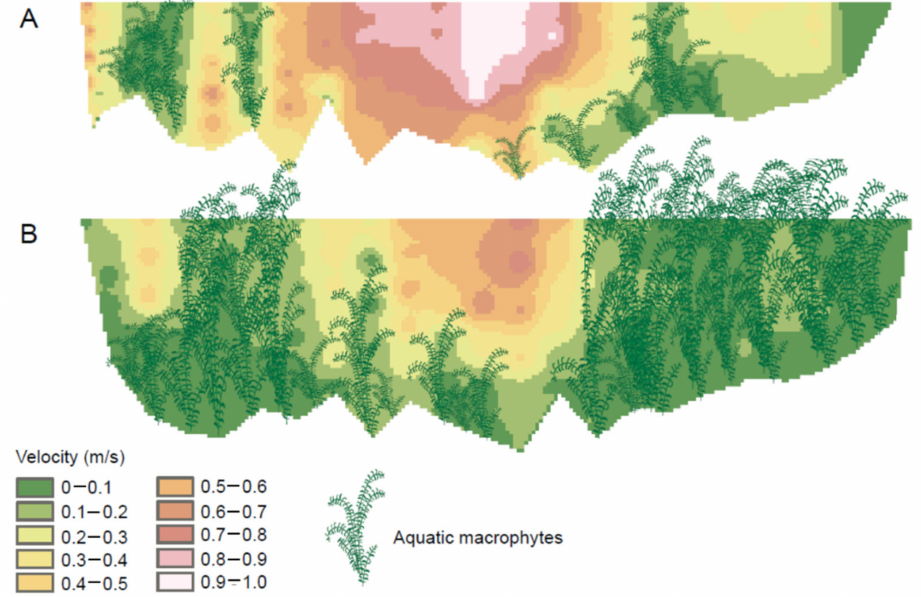
Figure 2. Seasonal evolution of channel hydraulics and velocity heterogeneity in a volcanic spring- fed river in northern California. Increasing plant biomass between seasons reduces high-velocity channels and provides velocity heterogeneity for biota. Seasonal minimum macrophyte biomass (93.5 g/m 2 Ash Free Dry Mass; March 2011) ( A ) and maximum macrophyte biomass (390.9g/m 2 Ash Free Dry Mass; August 2011) ( B ). (Adapted from